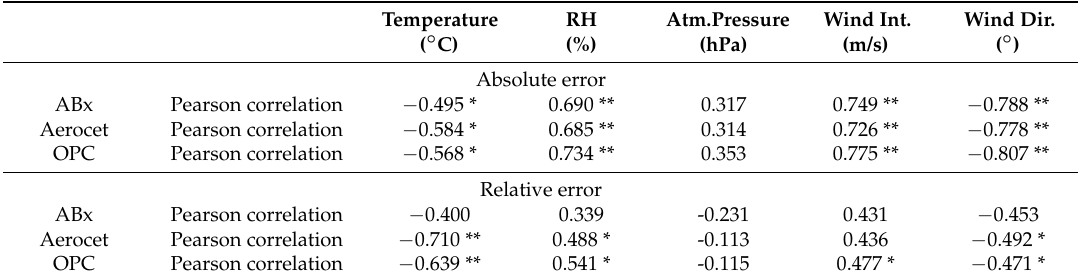
Table 12. Correlations between absolute and relative errors (direct-reading instruments vs. EPA WINS) and meteorological parameters (RH: relative humidity; Atm. pressure: atmospheric pressure; Wind int.: wind intensity; Wind dir.: wind direction). ** Correlation is significant at the 0.01 level (2-tailed); * Correlation is significant at the 0.05 level